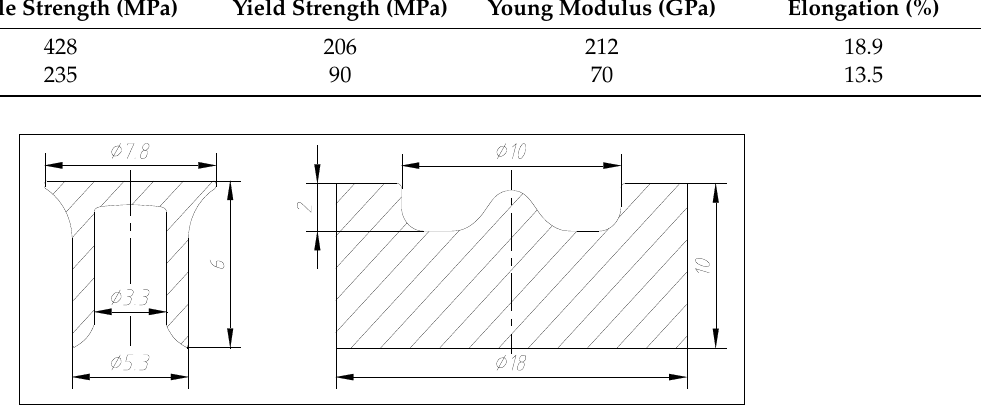
Figure 1. Geometry and sizes of the rivet and die (Unit: mm).